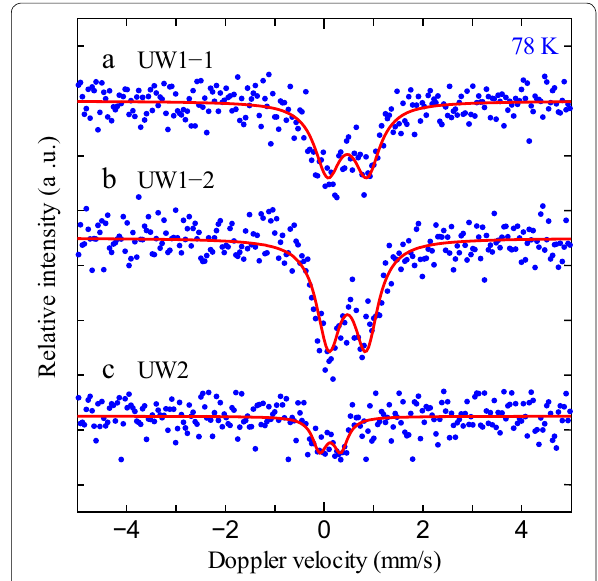
Fig. 4 Mössbauer spectra at 78 K of Japanese cedar umoregi wood. (a) UW1-1 (heartwood), (b) UW1-2 (sapwood), and (c) UW2 (heartwood). Red solid line is a fitting curve line